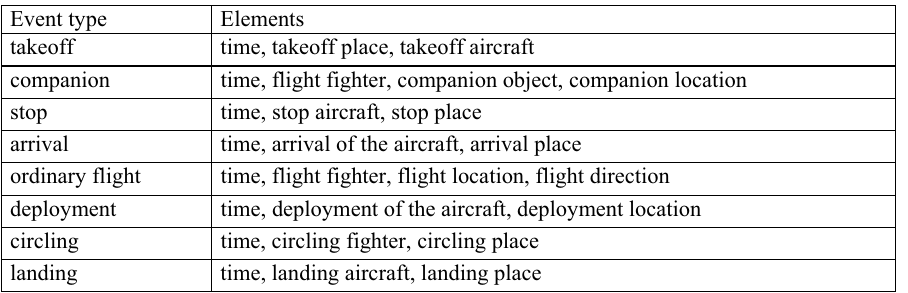
Table 1. Typical events